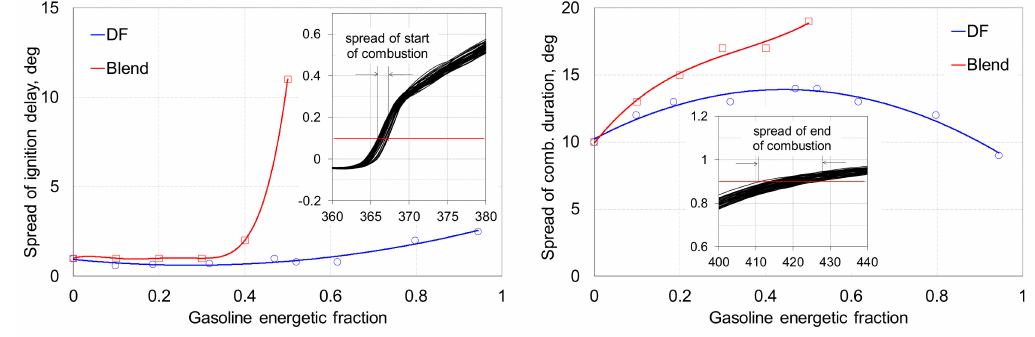
Figure 15. Stability of heat